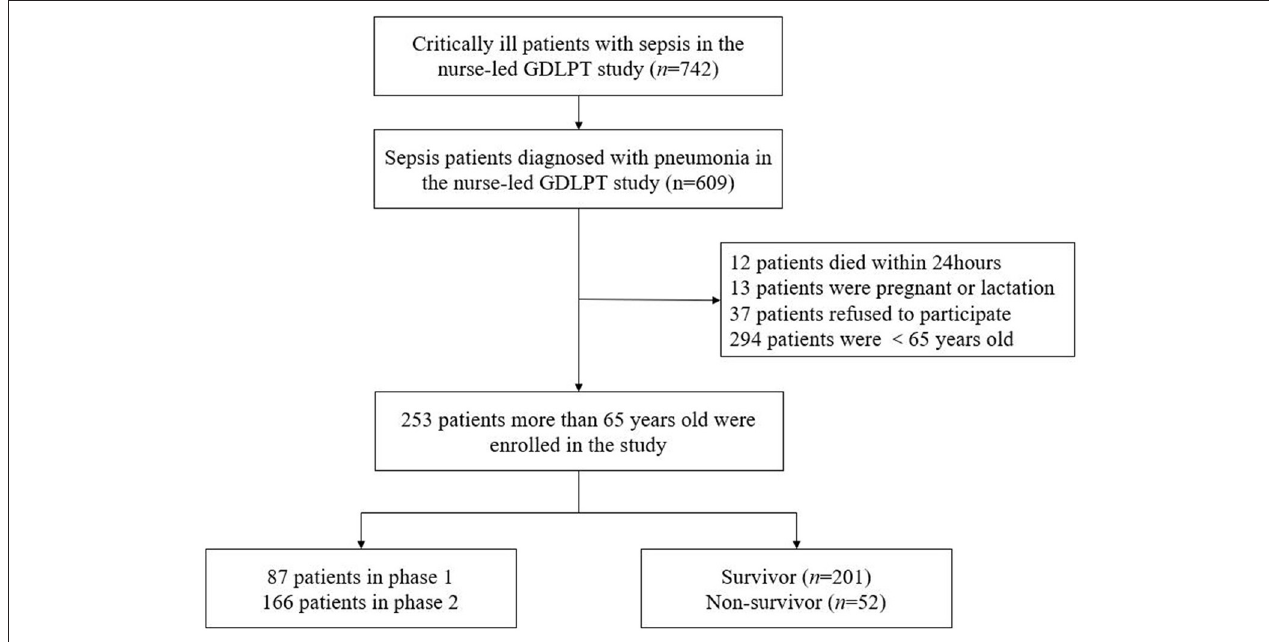
FIGURE 1 | The flowchart of patients screening and selection in this